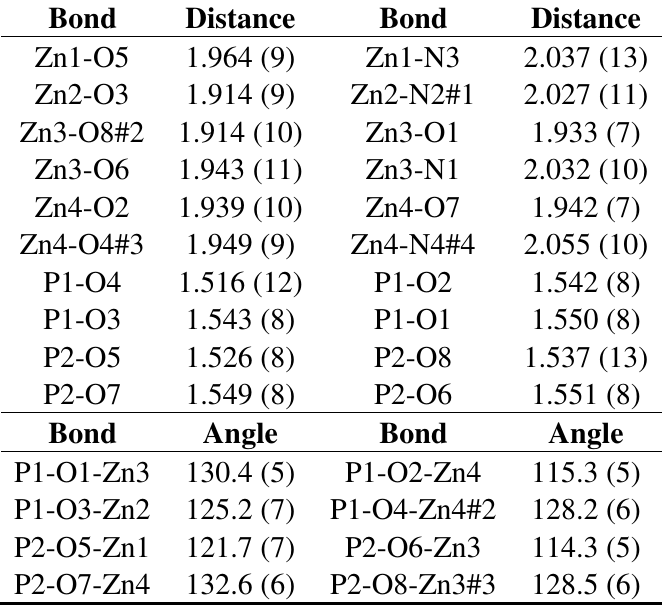
Table 1. Selected bond distances (Å) and angles ( ° ) in 1